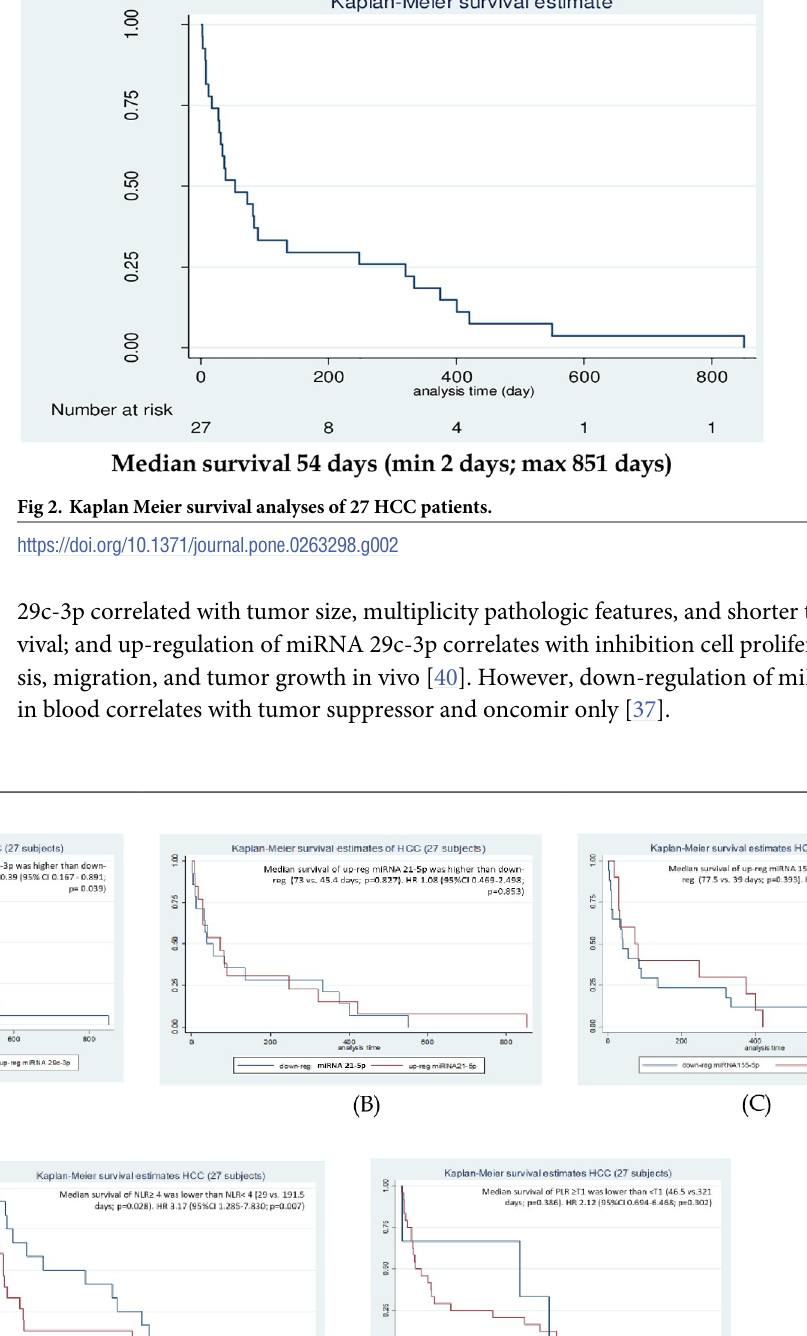
Fig 3. Kaplan Meier survival analyses of HCC subjects based on miRNAs, NLR, and PLR(T1). (A) Kaplan Meier survival based on miRNA 29c-3p regulation; (B) Kaplan Meier survival based on miR21-5p regulation; (C) Kaplan Meier survival based on miRNA155-5p regulation; (D) Kaplan Meier survival based on NLR cut off; and (E) Kaplan Meier survival based on PLR-Tertil 1 cut off.